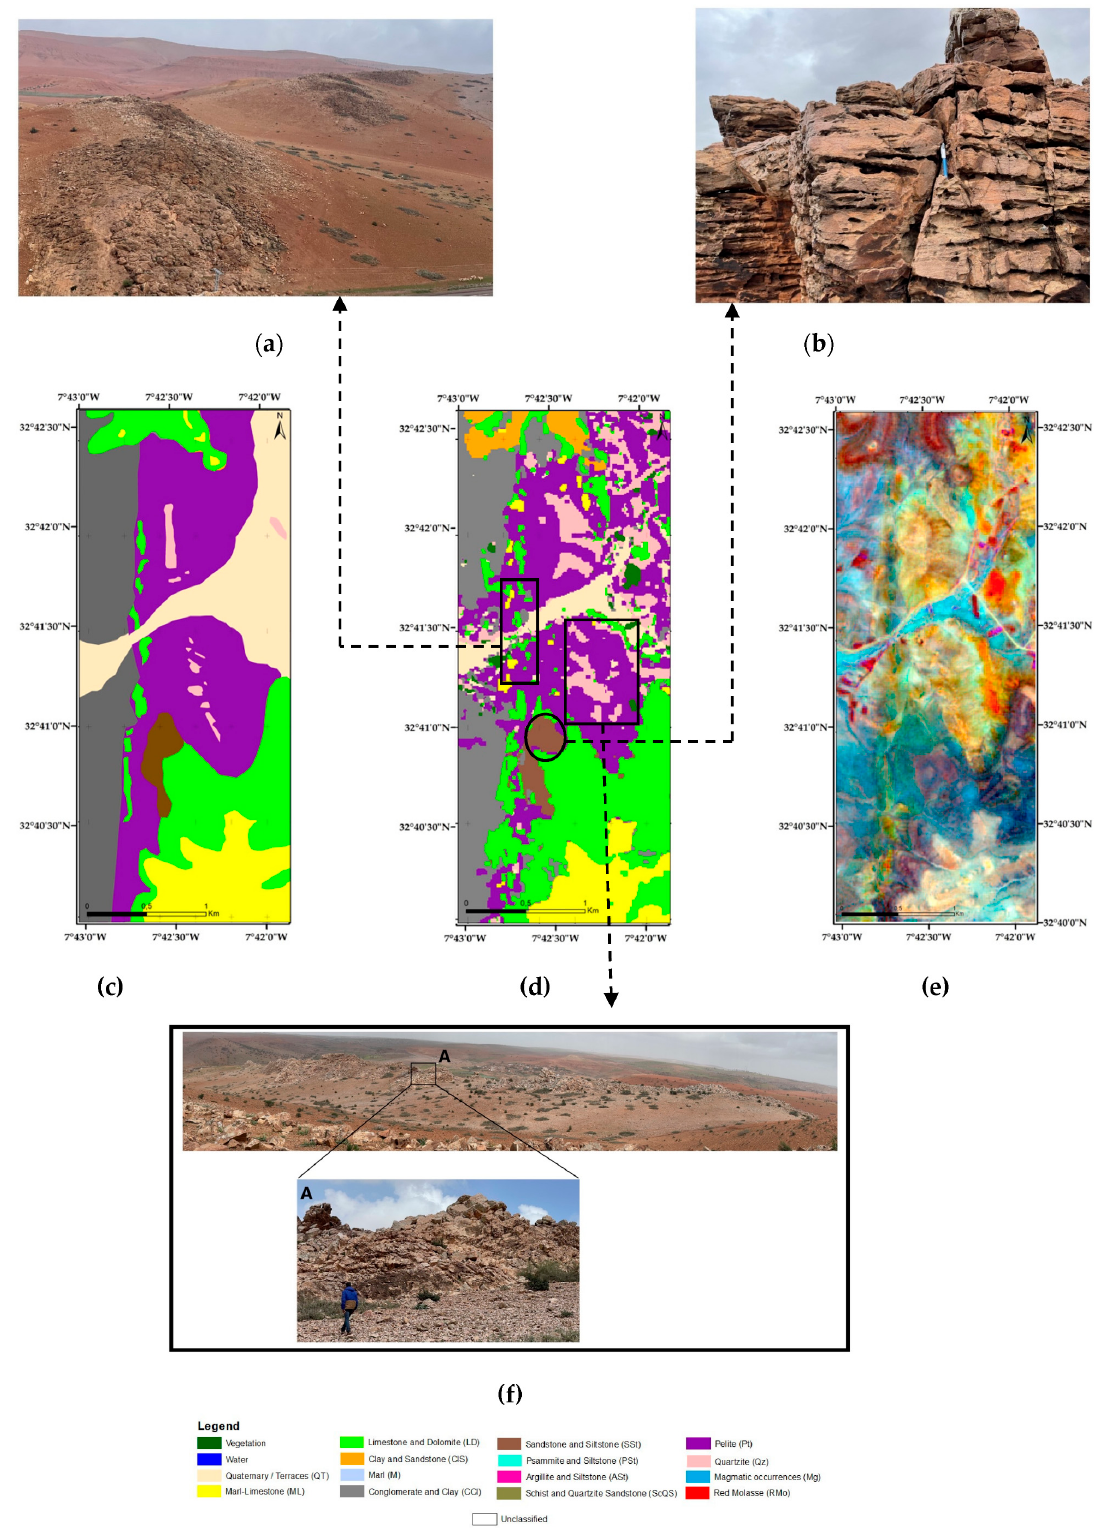
Figure 10. Validation of the proposed approach at the magnified area of Foum el M’jez: ( a ) fractured limestone and dolomite (LD); ( b ) sandstone and siltstone (SSt); ( c ) existing geological map; ( d ) lithological map using DST; ( e ) enhanced color composite; ( f ) panoramic view of the basement outcrop with A: the Zoom to the Quartzite (Qz).